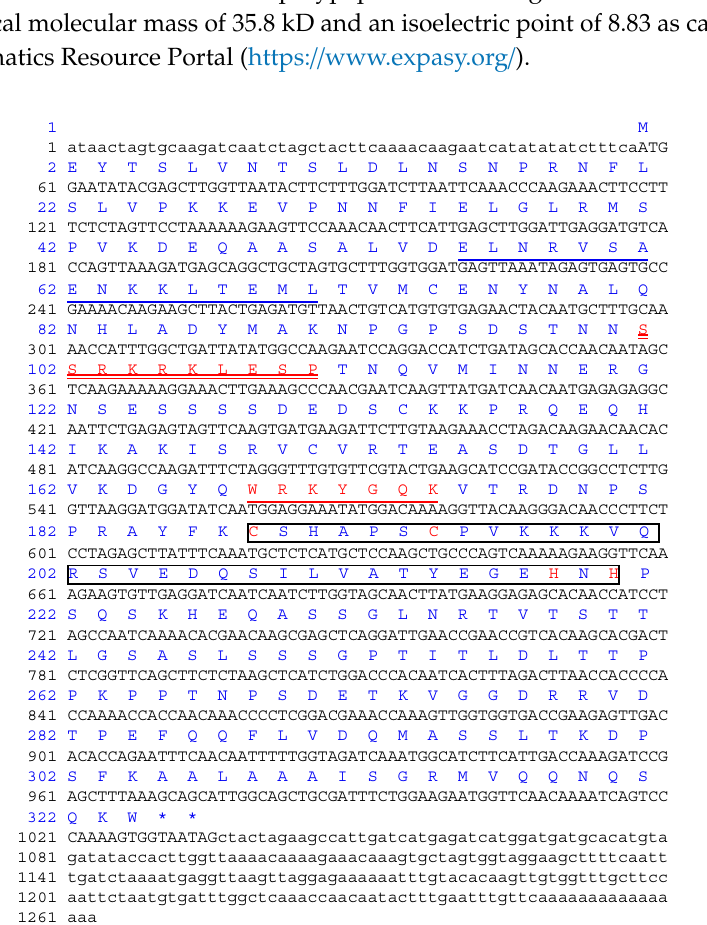
Figure 1. The nucleotide and deduced amino acid sequences of AaWRKY40 cDNA. A WRKY domain containing an invariant WRKYGQK sequence is indicated in red and underlined, a putative zinc-finger motif is in box and the C2H2 motif in red . A nuclear localization signal (SSRKRKLESP) is marked in red and double underlined. Putative leucine zipper motif is underlined.